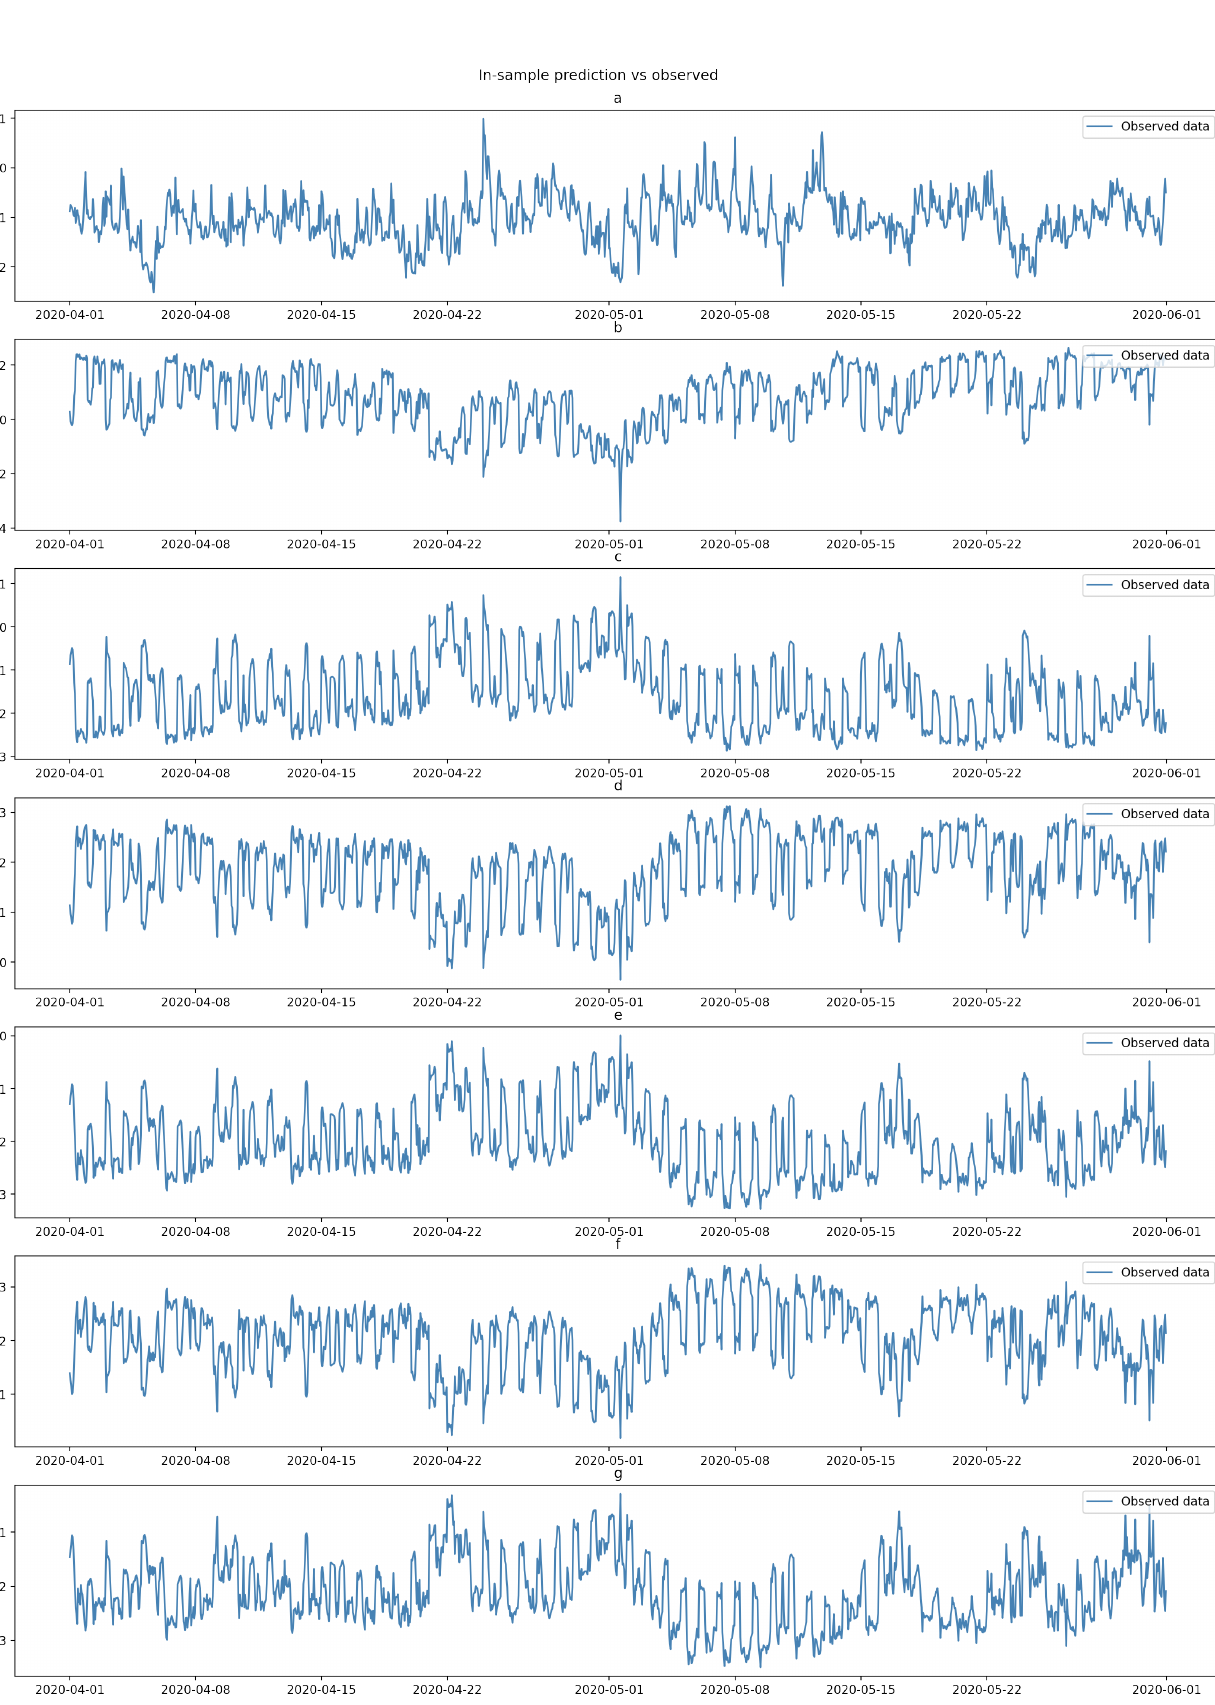
Figure 4. From top to bottom, the observed data for all 7 standardized parameters a, b, c, d, e, f and